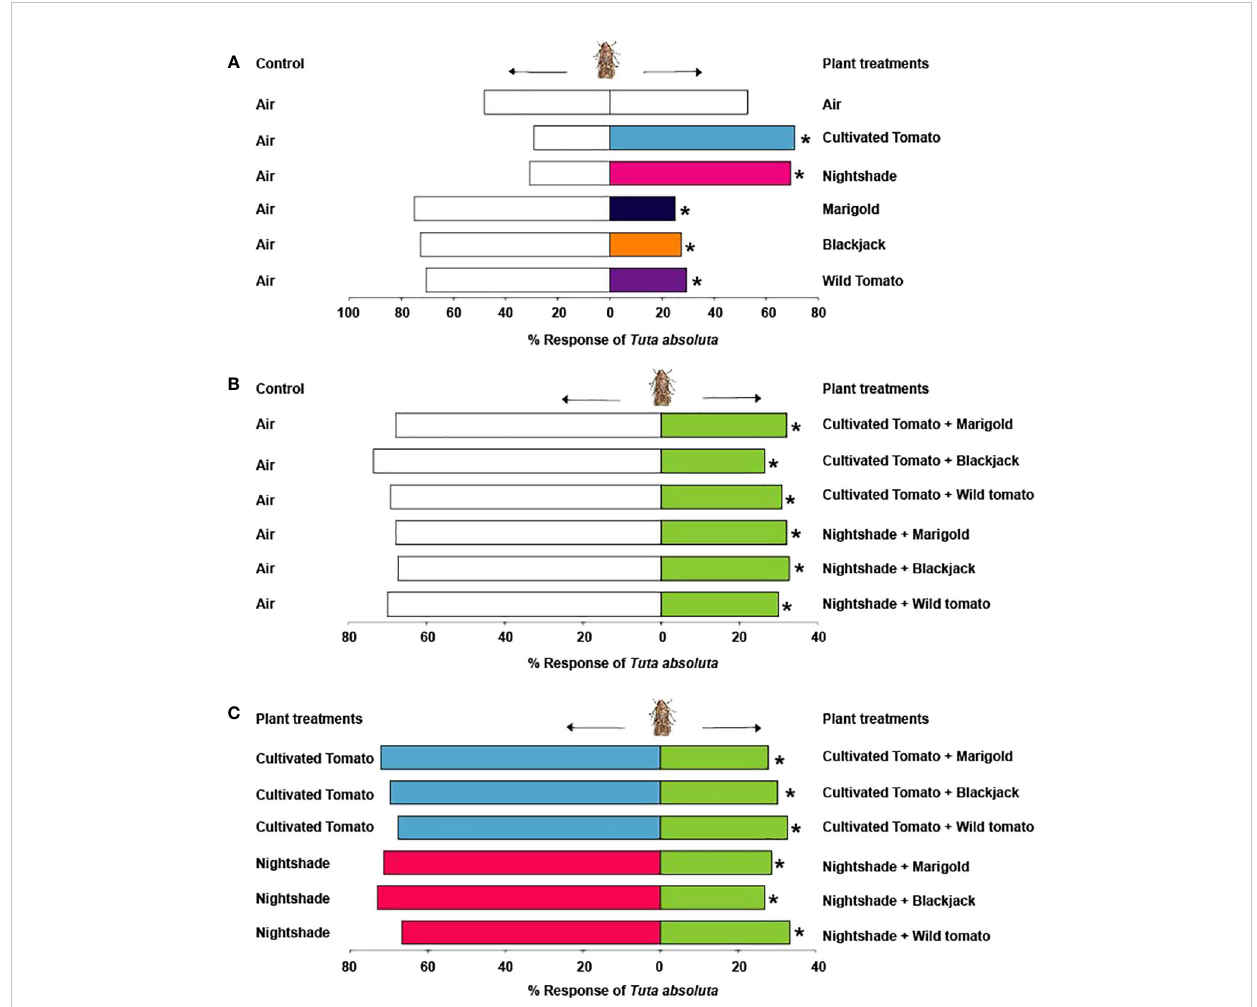
FIGURE 2 Behavioural response of Tuta absoluta to (A) Solanaceae and Asteraceae plants relative to air control, (B) Combination of Solanaceae and Asteraceae plants relative to air control, (C) Combination of Solanaceae and Asteraceae plants relative to the Solanaceae plants. Asterisks (*) indicate signi fi cant differences (Chi-square test: P =